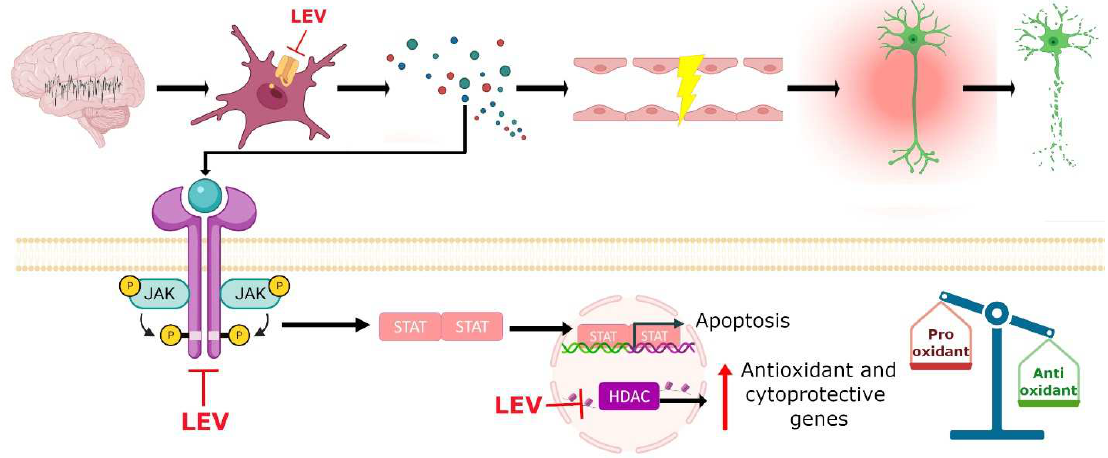
Figure 7. Anti-inflammatory effect of LEV. Seizures induces the activation of microglia, which in turn releases proinflammatory mediators, such as TNF-α, IL-1β, IL-6, etc. These cytokines promote the brain blood– brain barrier (BBB) damage and sustained neuronal inflammation leading to seizures and neurodegeneration, which activates further inflammation, establishing a vicious circle. The anti-inflammatory mechanism of LEV may be related to the voltage-activated Ca 2+ channel inhibition present in the microglia (purple cell). This results in glia non-activation and thus the attenuation of inflammation. LEV also inhibits the JAK2-STAT3 signaling pathway. LEV can act as an HDAC inhibitor promoting the transcription of antioxidant and cytoprotective genes, restoring the oxidation–reduction balance.